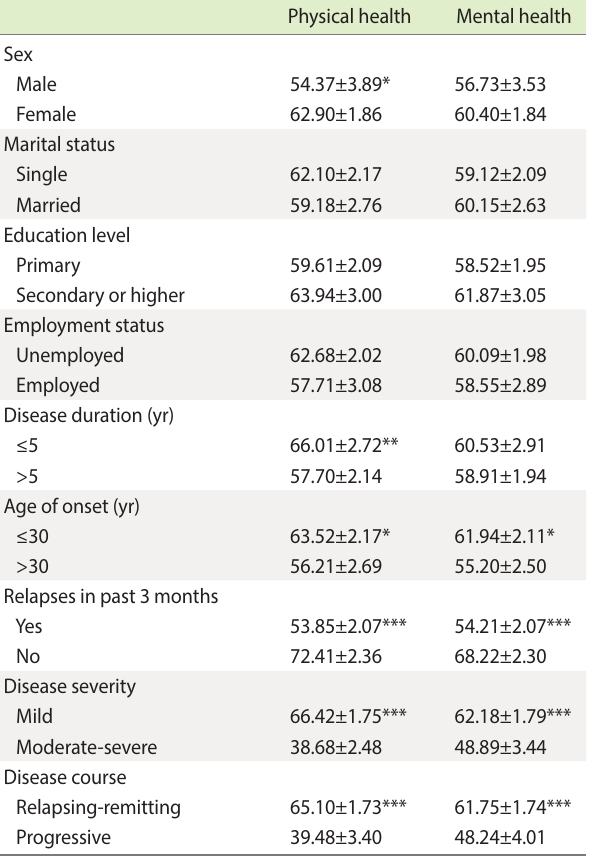
Table 2. Mean physical and mental health composite scores by de- mographic and clinical variables